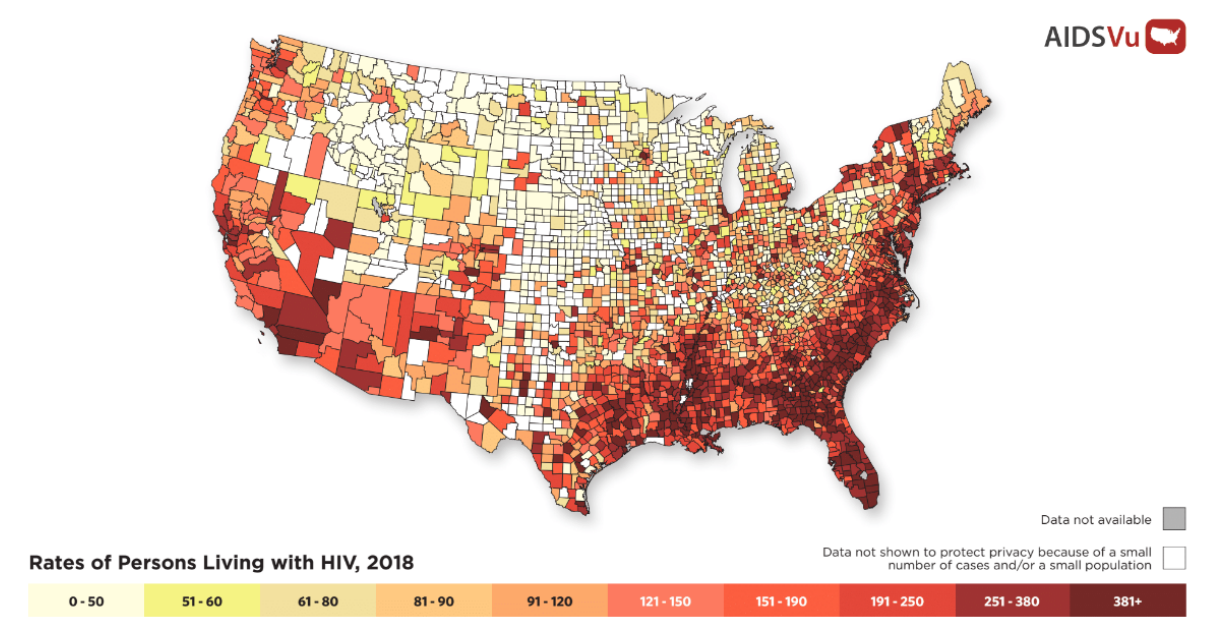
Figure 2. AIDSVu map of HIV prevalence at the county level,